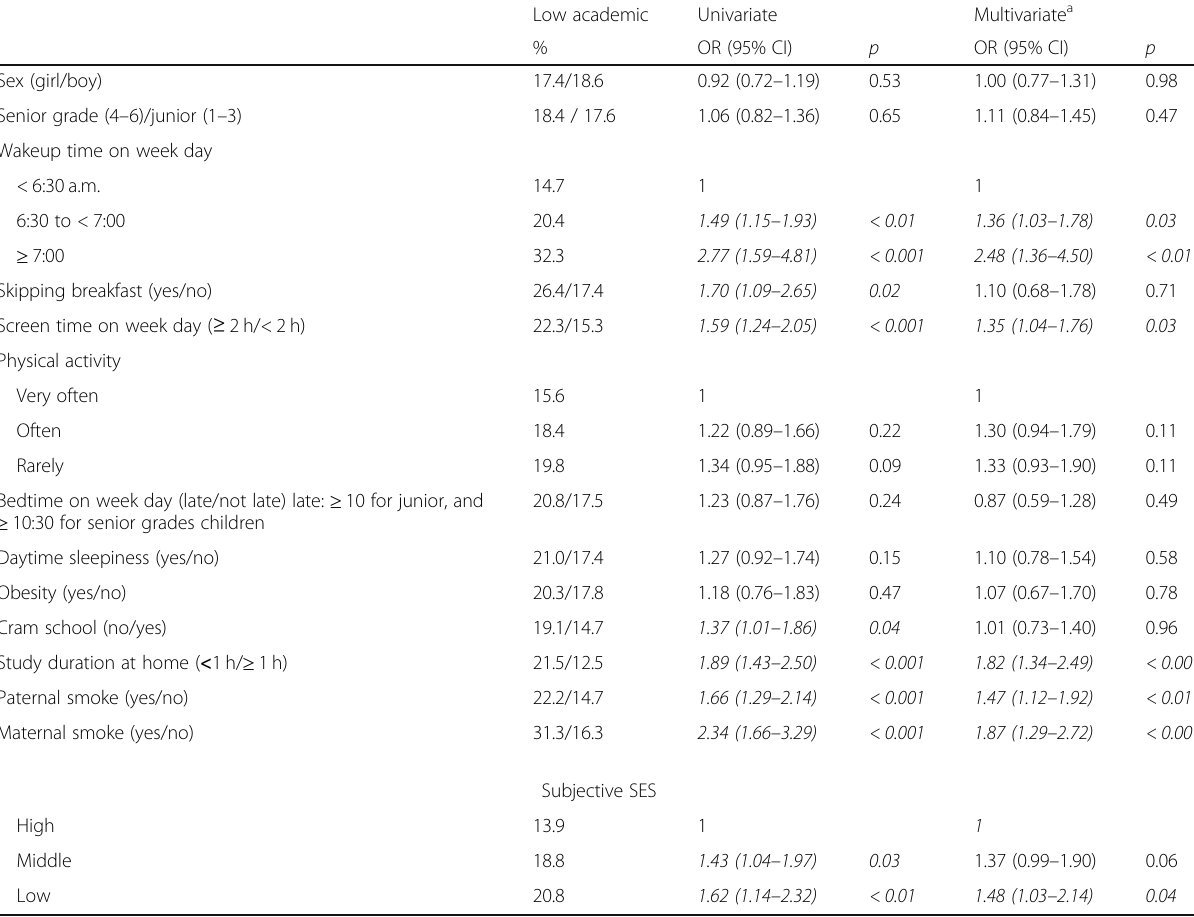
Table 2 Overall analyses on low academic performance n =